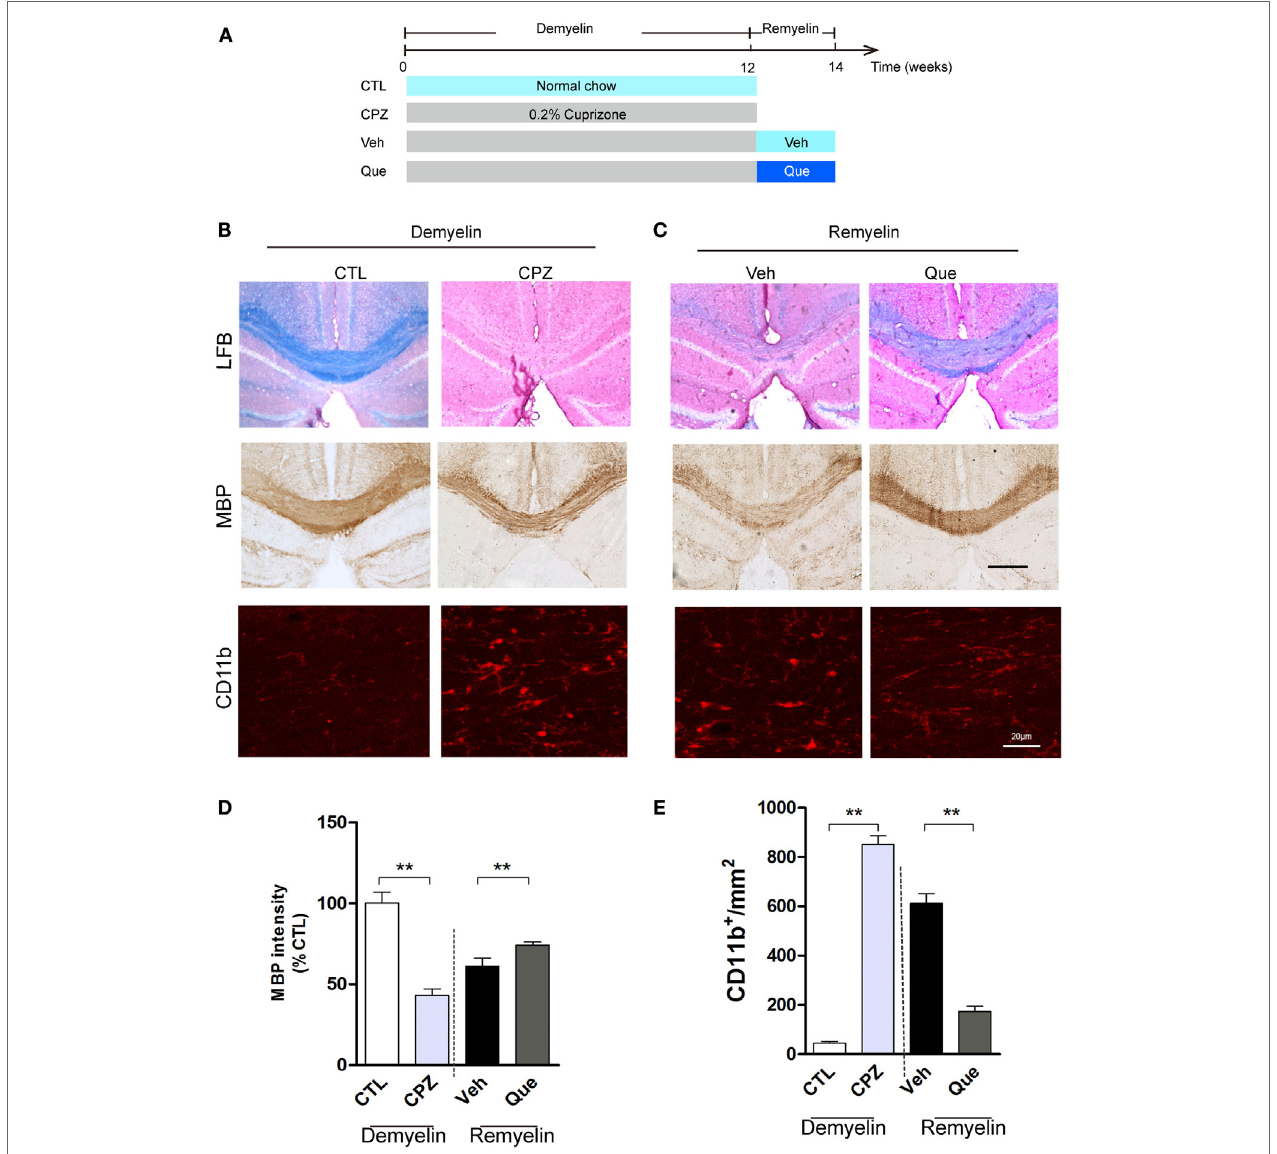
FigUre 1 | effect of Que on microglial activation and remyelination in cPZ-induced chronic demyelinating mouse model . (a) Schematic diagram displaying the time course and Que (10 mg/kg/day) treatment on CPZ-induced demyelination and remyelination. C57BL/6 mice were given CPZ for 12 weeks for chronic demyelination and start remyelination after CPZ withdrawal. (B) Representative Luxol fast blue staining, MBP and CD11b IF staining for corpus callosum (CC) mediolateral area of mice fed with or without CPZ. (c) Representative Luxol fast blue staining, MBP and CD11b IF staining for CC mediolateral areas of mice fed with or without Que after CPZ withdraw. (D) Quantification for optical density of MBP expression in CC of indicated groups. (e) Quantification of CD11b + cells (activated microglia) in CC. The scale bars are 200 μm and 20 μ m, respectively. Data represent means ± SEM ( n = 6 in each group), ** p < 0.01 between indicated